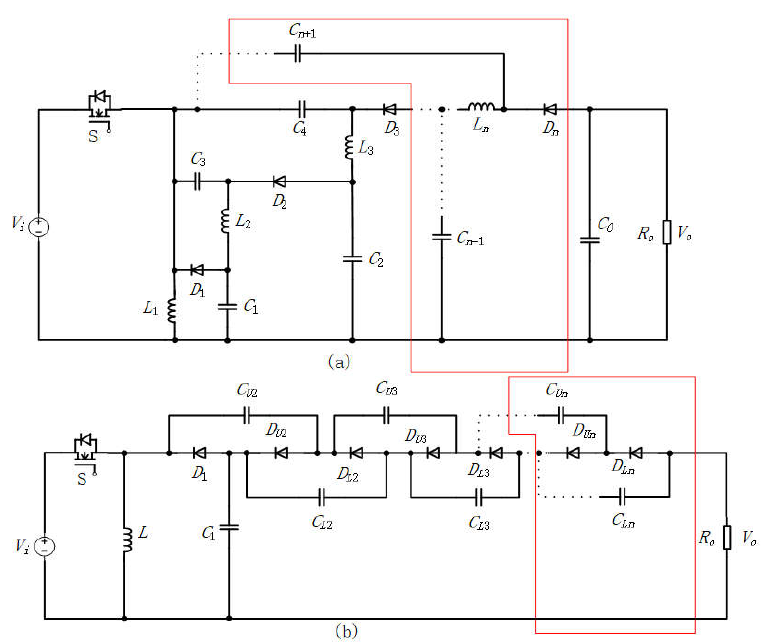
Figure 26. Multi-level buck-boost converters with single DC source. ( a ) [55]. ( b ) [56]. A multi-level buck–boost converter with a voltage multiplier was introduced in [56].